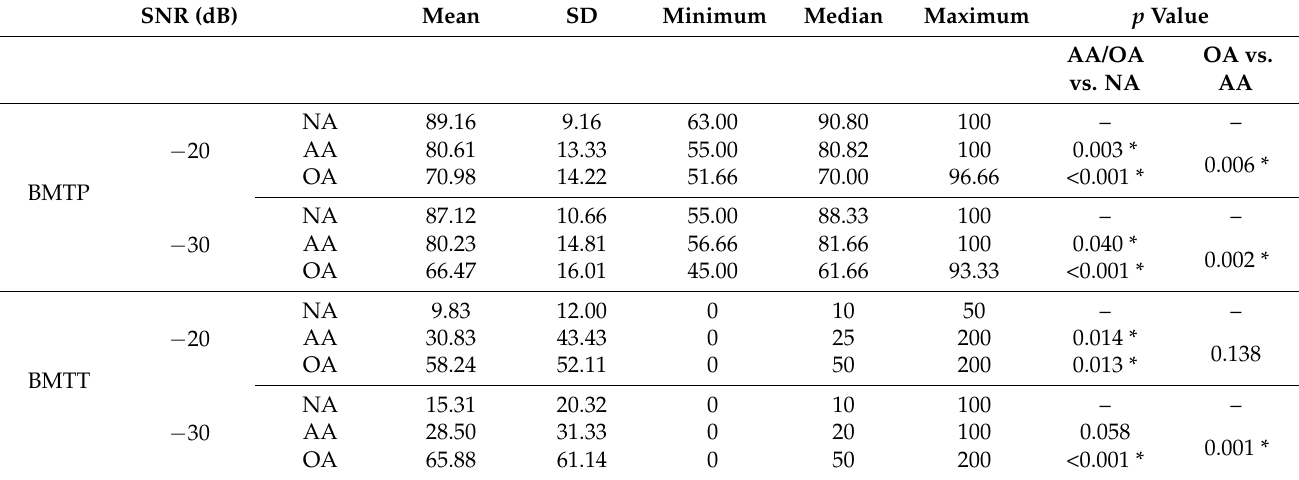
Table 2. Descriptive statistics and comparison of performance in percentage of correct responses (BMTP) and target sound detection threshold (BMTT) for the three groups for the backward masking test (BMT), according to the signal-to-noise ratio